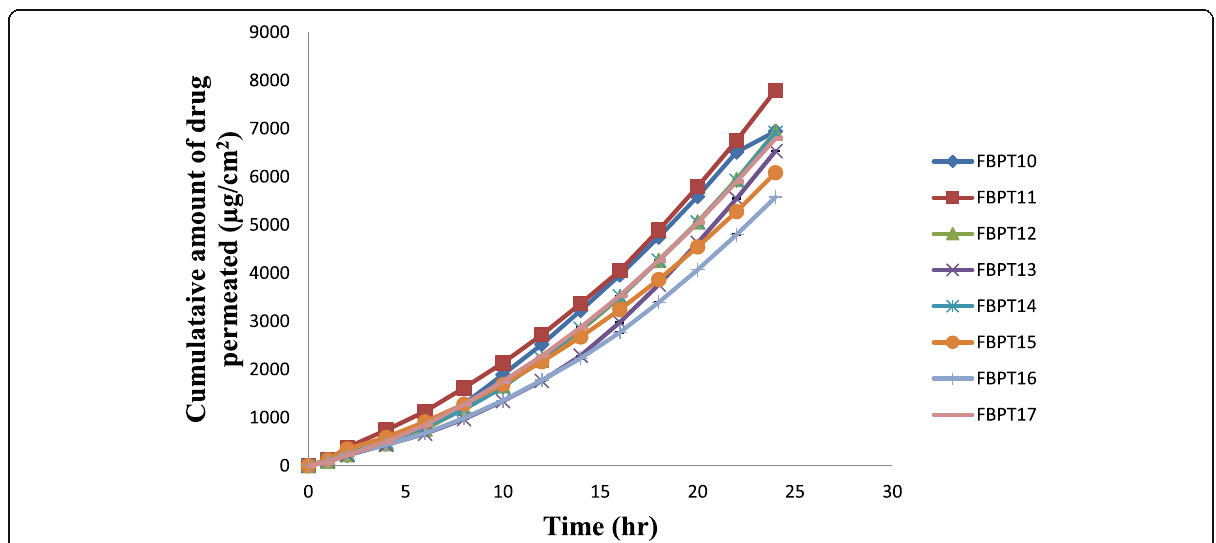
Fig. 9 Ex vivo drug permeation profile of flurbiprofen from transdermal films